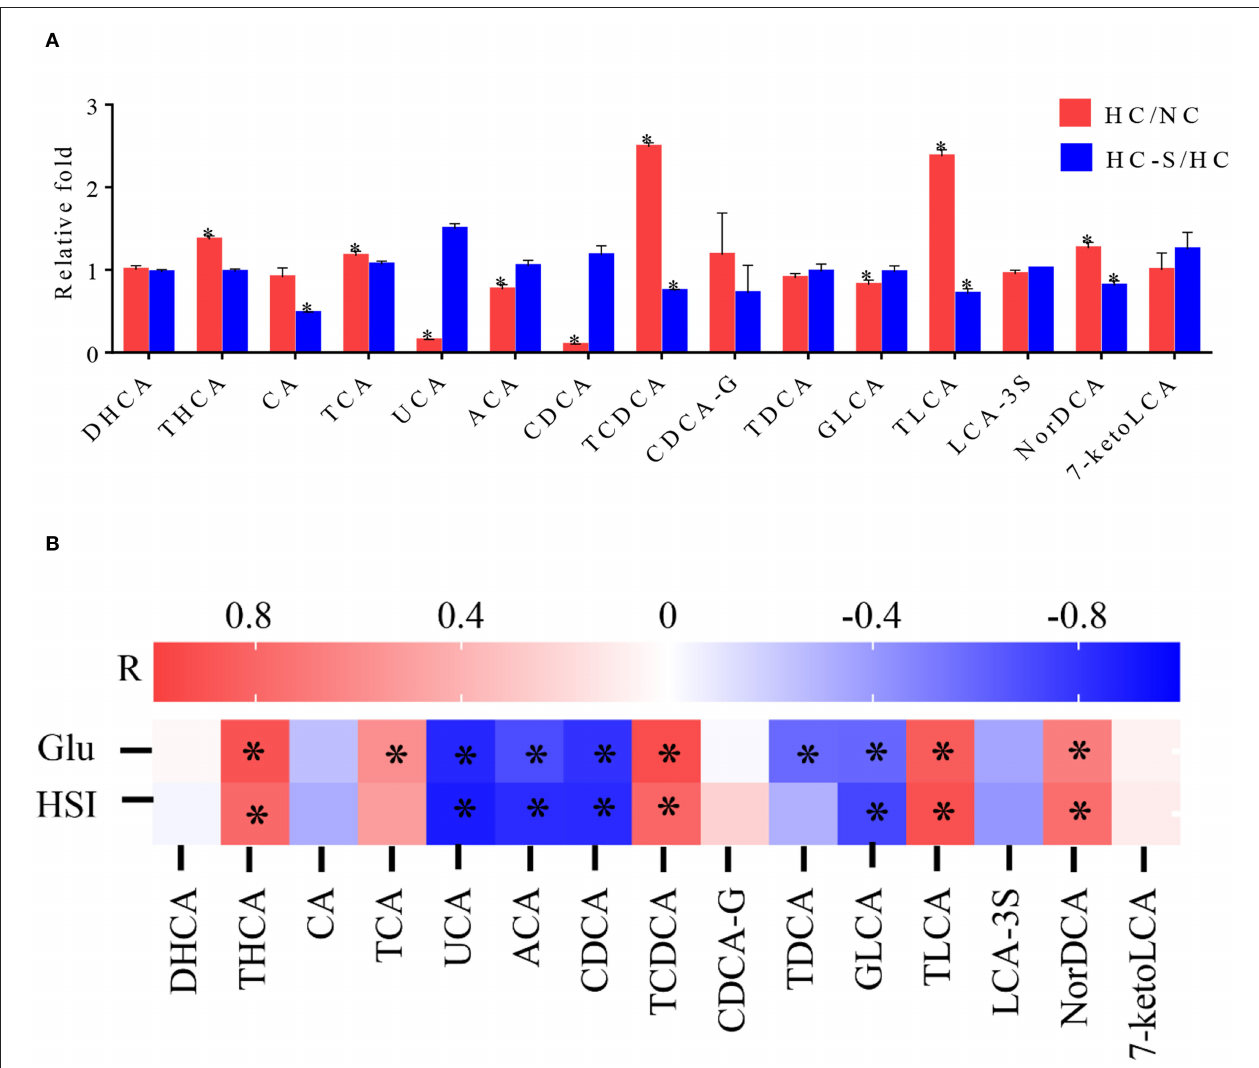
FIGURE 4 | Influence of dietary SJ on the serum profile of bile acid (BA) in swamp eel fed HC diet. (A) Fold changes of 15 BA in the HC group relative to the mean values of the NC group and the HC-S group relative to the mean values of the HC group, (B) Heatmaps of Spearman’s correlation coefficients of 15 BA with representative metabolic markers. In the bar plots (A) , *indicate the statistical significance ( p < 0.05) between two groups. In the heatmaps (B) , R value indicates Spearman’s correlation coefficient, and *indicates the statistical significance ( p < 0.05) based on Spearman’s correlation. Values are presented as means ± SEM, n = 16 fish/diet. THCA, taurohyocholic acid; CA, cholic acid; TCA, taurocholic acid; UCA, ursocholic acid; ACA, allocholic acid; CDCA, chenodeoxycholic acid; TCDCA, taurochenodeoxycholic acid; CDCA-G, chenodeoxycholic acid-glucuronide; TDCA, taurodeoxycholic acid; GLCA, glycolithocholic acid; TLCA, taurolithocholic acid; LCA-3S, lithocholic acid-3-sulfate; NorDCA, nordeoxycholicacid; 7-ketoLCA, 7-Ketolithocholic